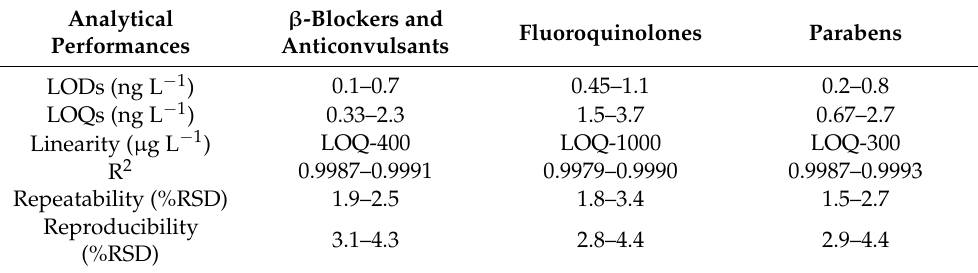
Table 2. Summary of analytical characteristics of the DMSPE-HPLC-DAD method for determination of β -blockers and anticonvulsants, fluoroquinolones and